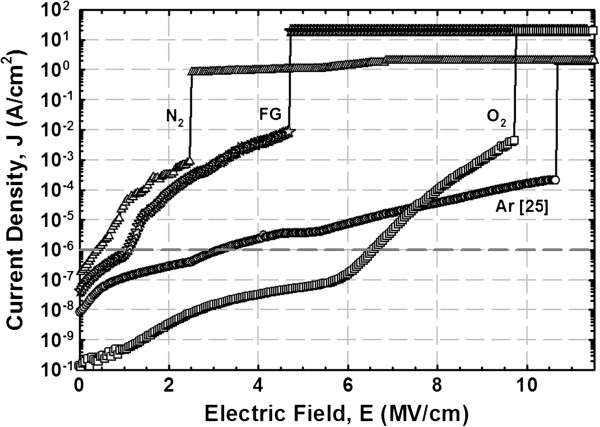
Comparison ofJ-E characteristics of Al/Y2O3/IL/GaN-based MOS capacitors.